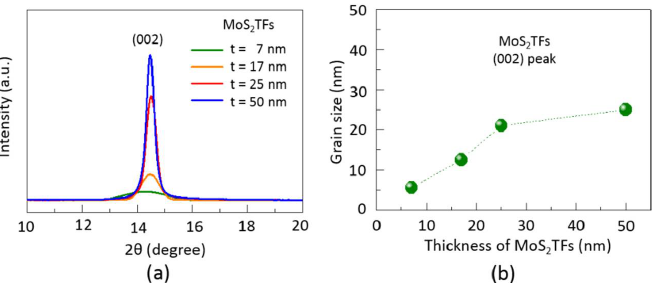
Figure 8. ( a ) XRD pattern of the MoS 2 TFs on sapphire with different thicknesses. ( b ) The grain size of MoS 2 TFs as a function of thickness.